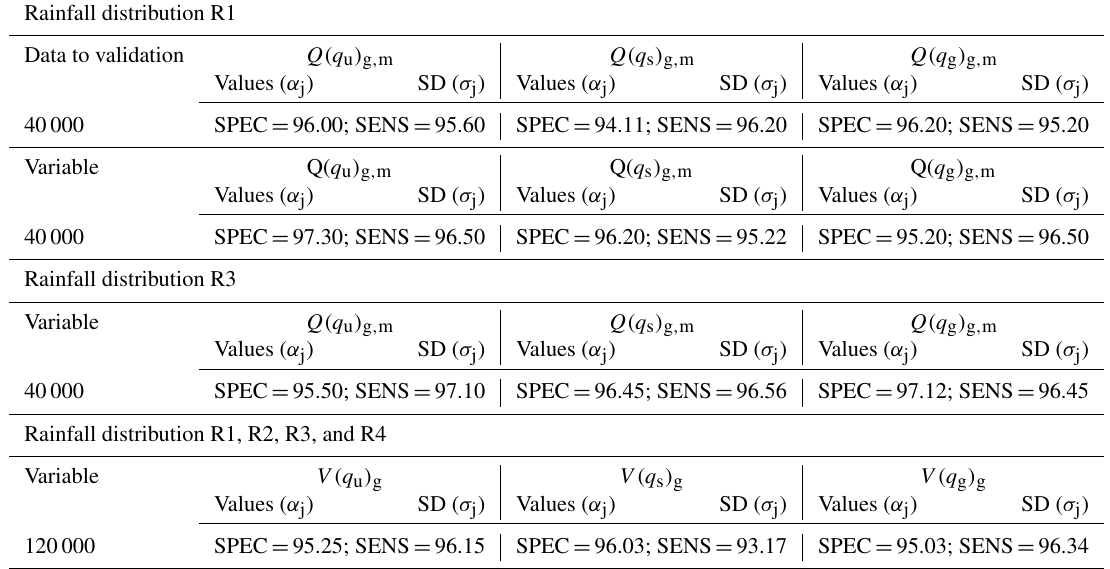
Table 3. Results of validation of logit models shown in Table 2. Rainfall distribution